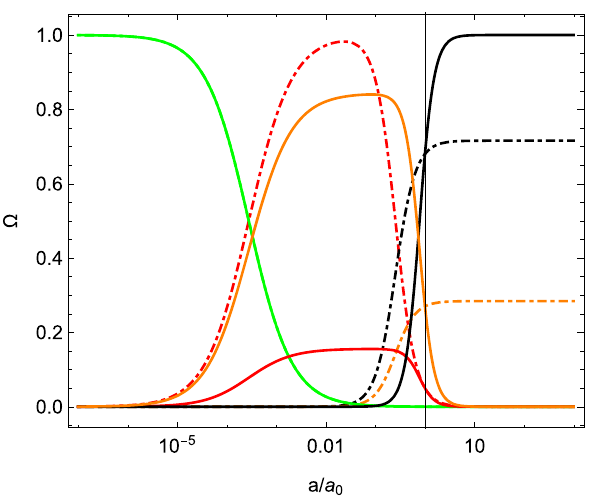
Fig. 5 The same as Fig. 4. The calculated deceleration parameter q as a function of a / a 0 . The calculations are carried out for the standard (cid:2) CDM model. The cosmic evolution, as well as the results regarding arbitrary initial perturbations, are shown in solid, dashed, and dotted curves. The zoomed-in plot illustrates the deceleration parameters in the vicinity of a / a 0 =